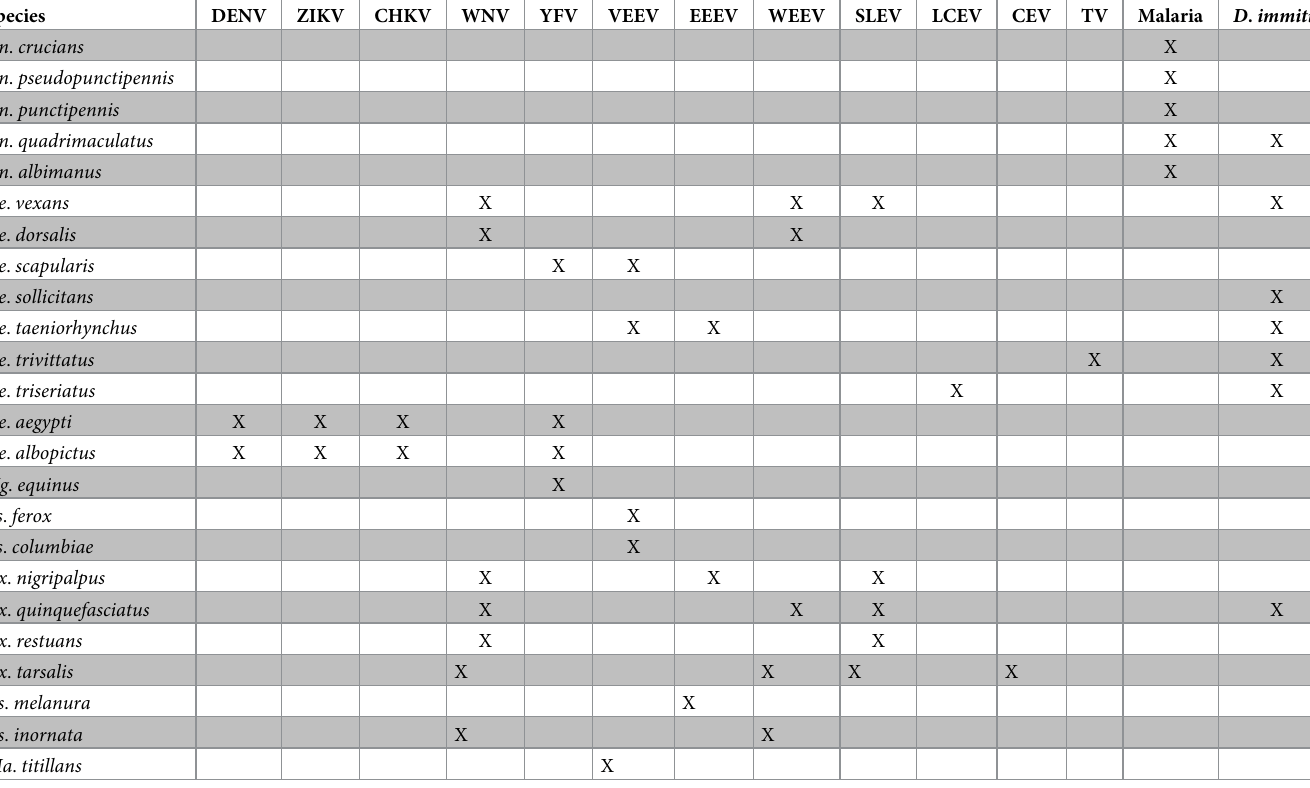
Table 4. Medical and veterinary importance of the mosquitoes of Nuevo Leo´n